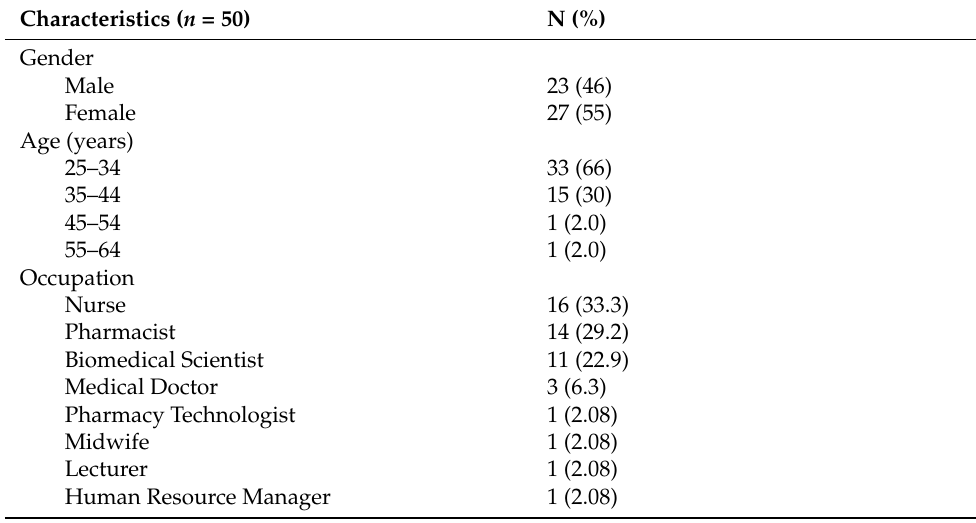
Table 1. Socio-demographics of the